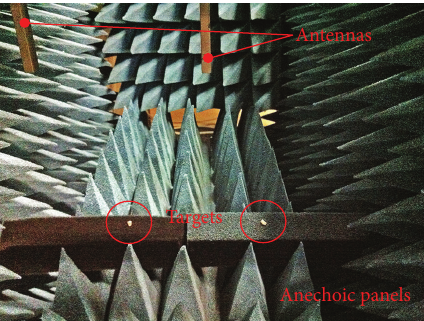
Figure 8: Measurement scenario: lateral view. The targets are the white dots placed on an anechoic base.